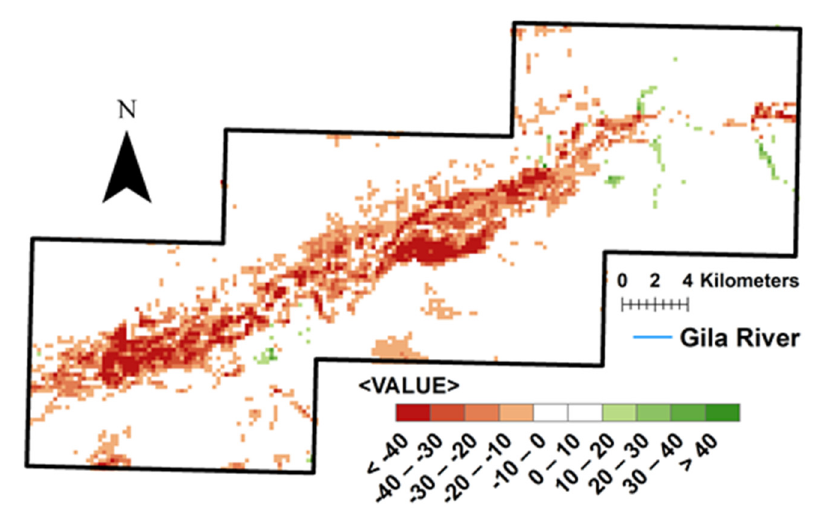
Figure 4. Map of vegetation change from 1996 to 2019. We subtracted the 250 m tessellation of vegetation cover in 1996 from the 250 m tessellation of vegetation cover in 2019. Areas in red indicate loss of vegetation, darker shades indicate greater loss. Areas in green indicate increased vegetation with darker shades indicating greater increases. Even though a large amount of area appears red, keep in mind that all the area in white experienced little to no change. See appendix for percent vegetation cover maps from 1996, 2007, and 2019.